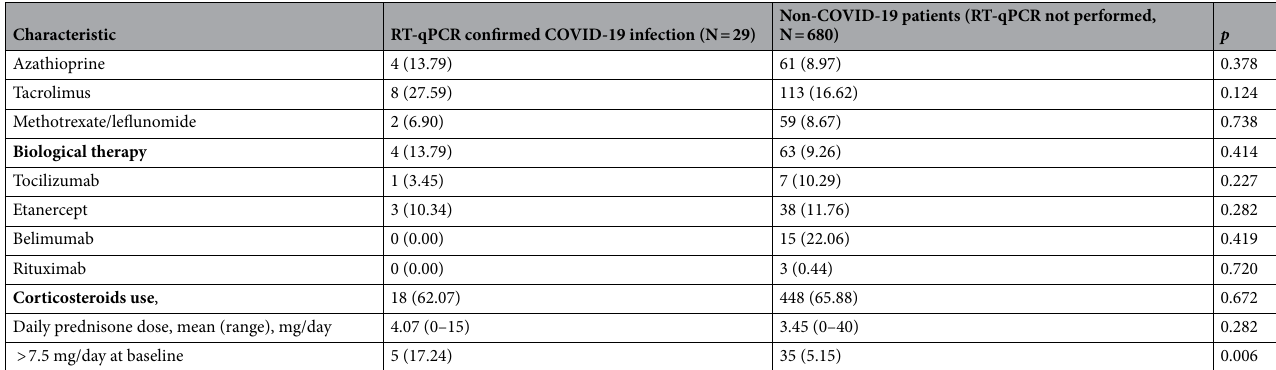
Table 1. Baseline demographic and disease characteristics of the lupus patients classified by COVID-19 status*. *Except where indicated otherwise, values are the number (%). RT-qPCR Reverse-transcriptase quantitative PCR; SLE Systemic lupus erythematosus; CLE Cutaneous Lupus Erythematosus; SLEDAI-2K Systemic Lupus Erythematosus Disease Activity Index 2000; SLICC-DI Systemic Lupus International Collaborating Clinics Damage Index. MMF mycophenolate mofetil; EC-MPS enteric-coated mycophenolate sodium; na not applicable. Reference ranges are as follows: anti-double-stranded DNA antibodies, < 15 IU per milliliter; serum C3 (mg/dL), 85 to 110; serum C4 (mg/dL), 10 to